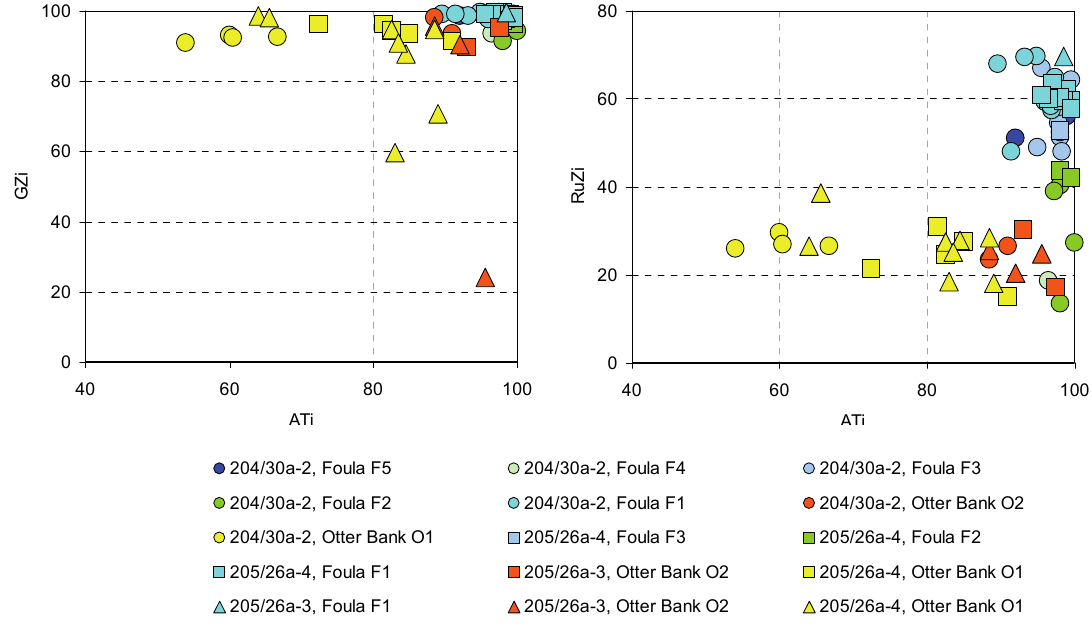
Figure 3. Correlation of the Triassic in Strathmore Fields wells 204/30a-2, 205/26a-3, and 205/26a-4 using heavy mineral provenance-sensitive ratio signatures. For well locations, see Figure 1. FF = Foula Formation, OBF = Otter Bank Formation, OSBF = Otter Bank Shale Formation